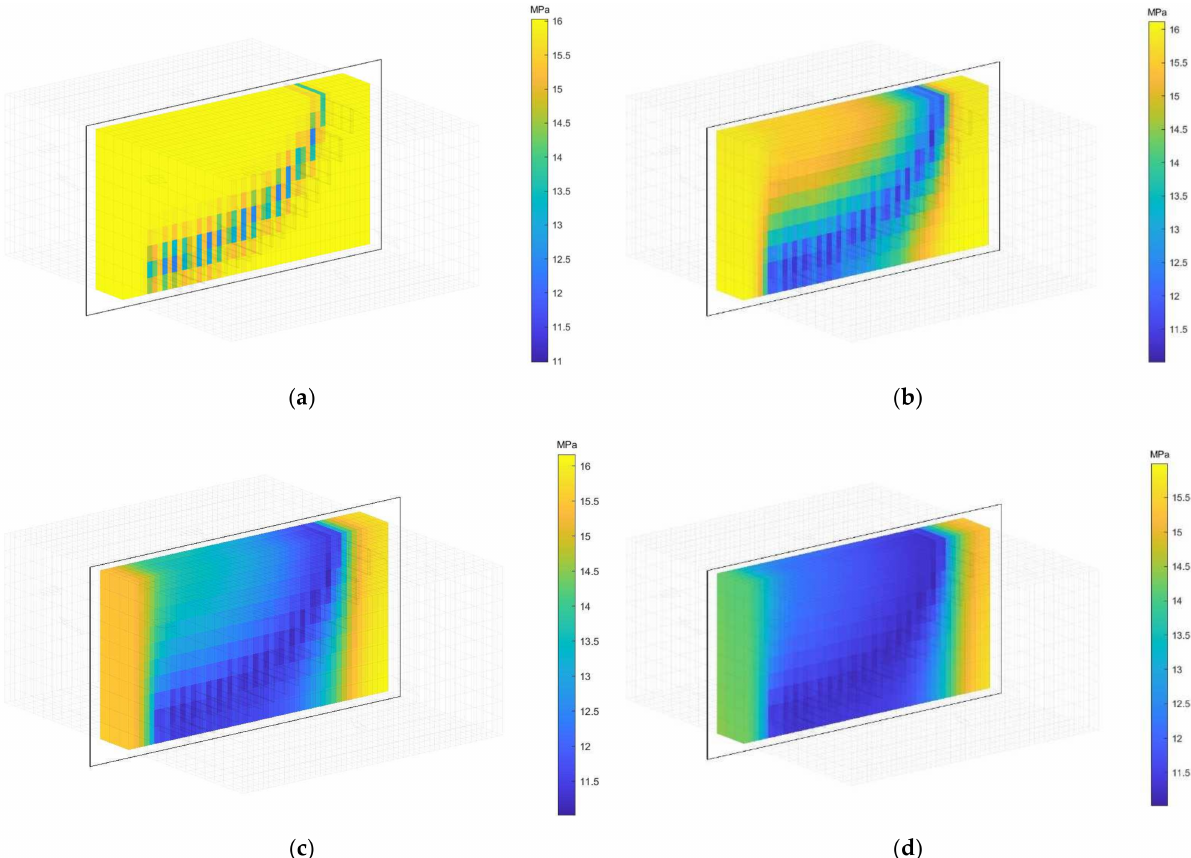
Figure 17. Static pressure of the reservoir in tilt-up case at production time ( a ) day 2, ( b ) day 30, ( c ) day 90, and ( d ) day